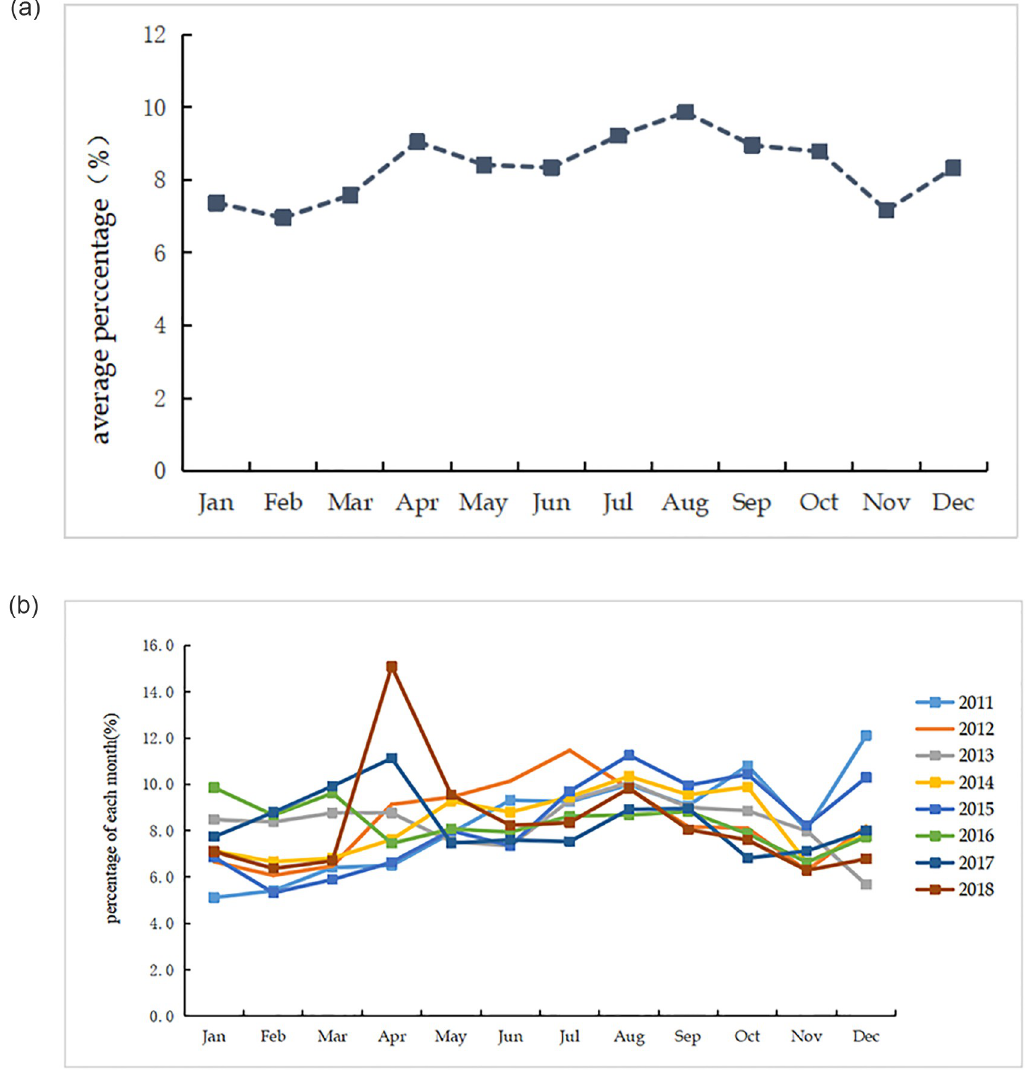
Fig 2. a: The average percentage of each month during 2011-2018. b: The percentage of each month from 2011 to 2018.